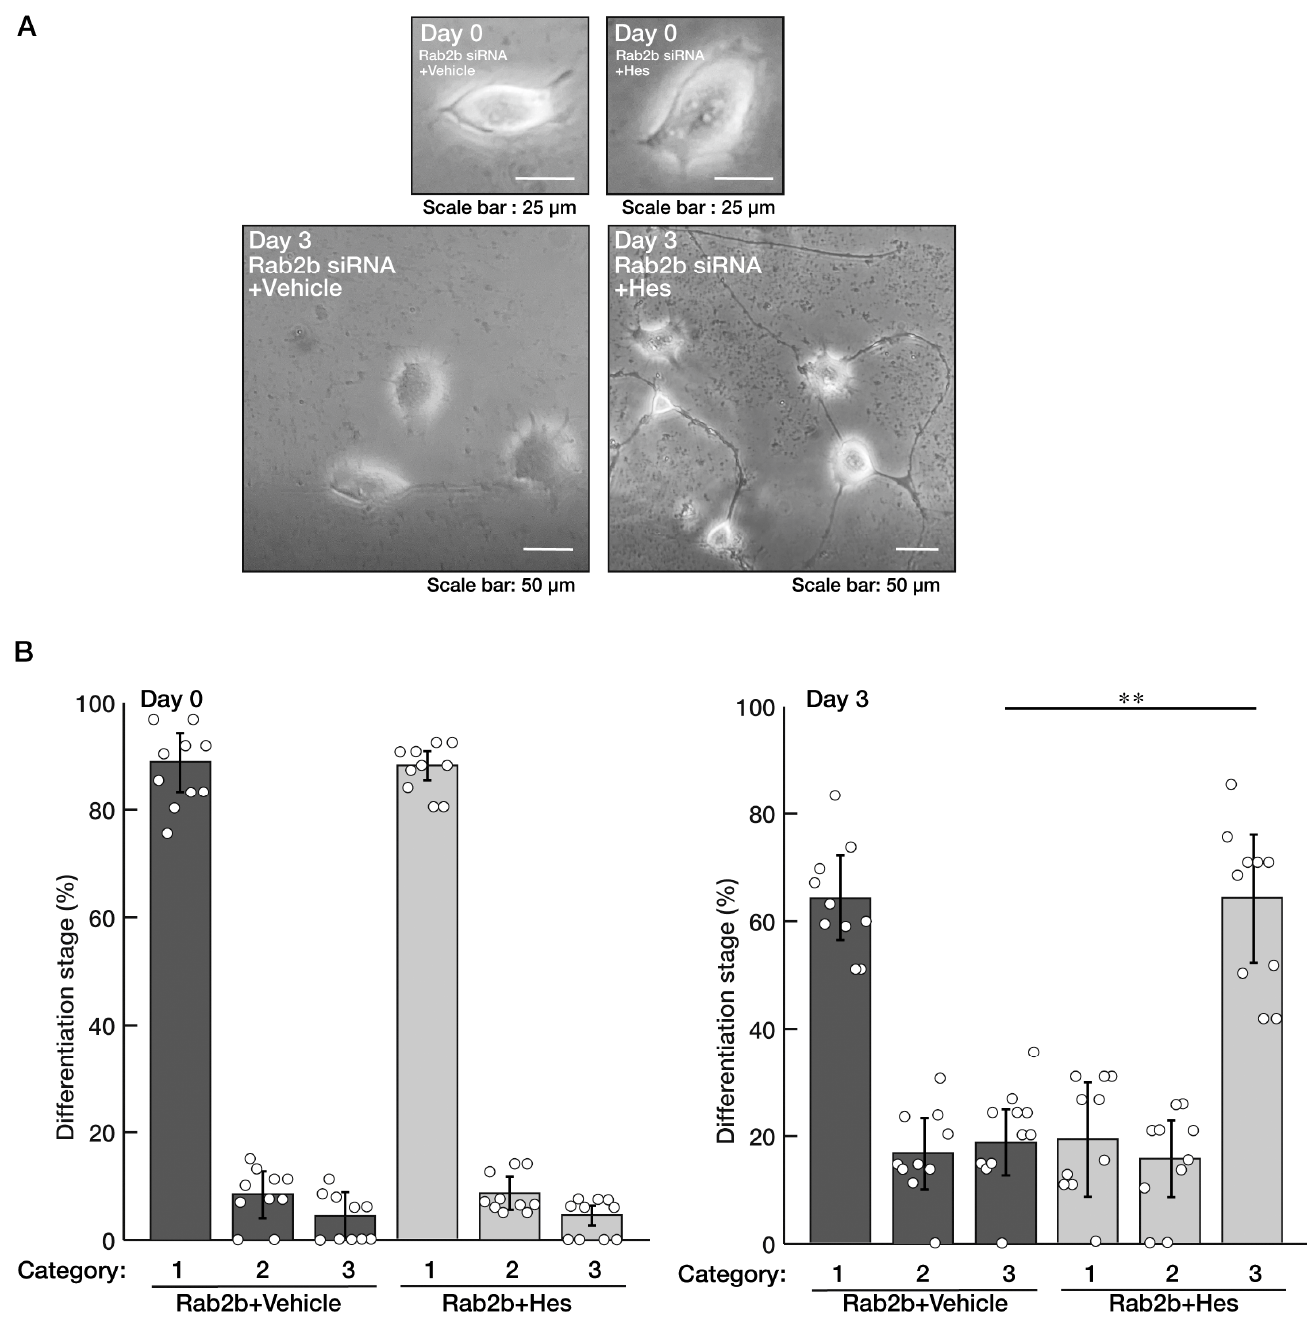
Figure 5. Hesperetin recovers decreased differentiated phenotypes induced by Rab2b knockdown. ( A , B ) N1E-115 cells were transfected with Rab2b siRNAs and treated with a control vehicle or hesperetin (Hes, 1 μ M) for 0 or 3 days. Their cell morphologies were divided into 3 categories and statistically depicted as graphs (** p < 0.01; n = 10 fields). White circles show percentages in the respective independent experiments.